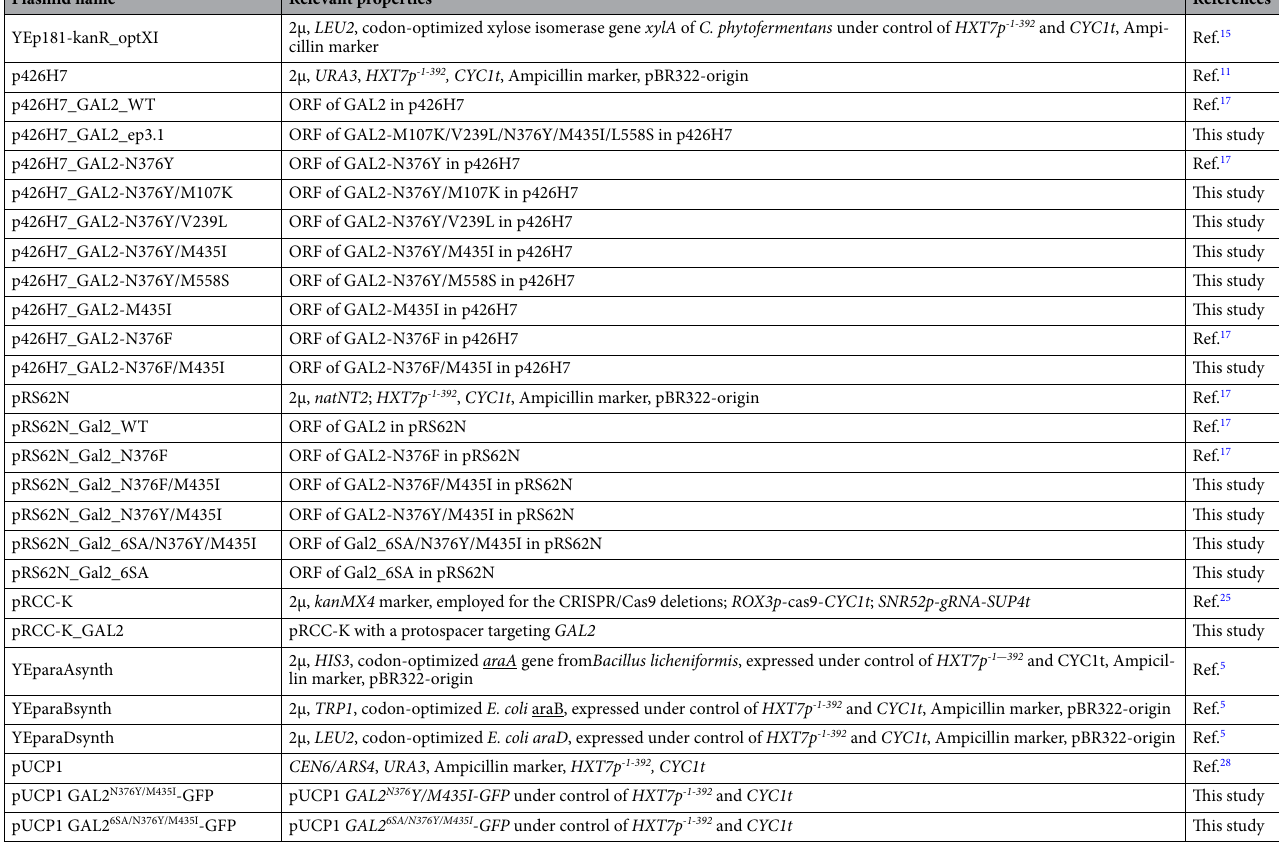
Table 2. Plasmids used in this study . Under “relevant properties”, promoters and terminators are denoted by suffixes “p” and “t”, respectively; ORF, open reading